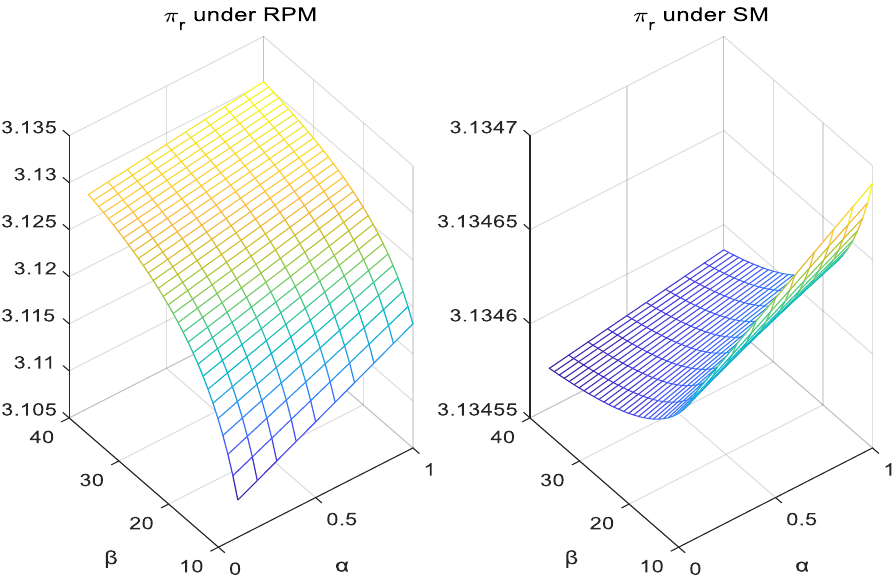
Figure 8. Retailer’s profit vs. fixed cost coefficient and environmental benefit coefficient under RPM ( left ) and SM ( right ).